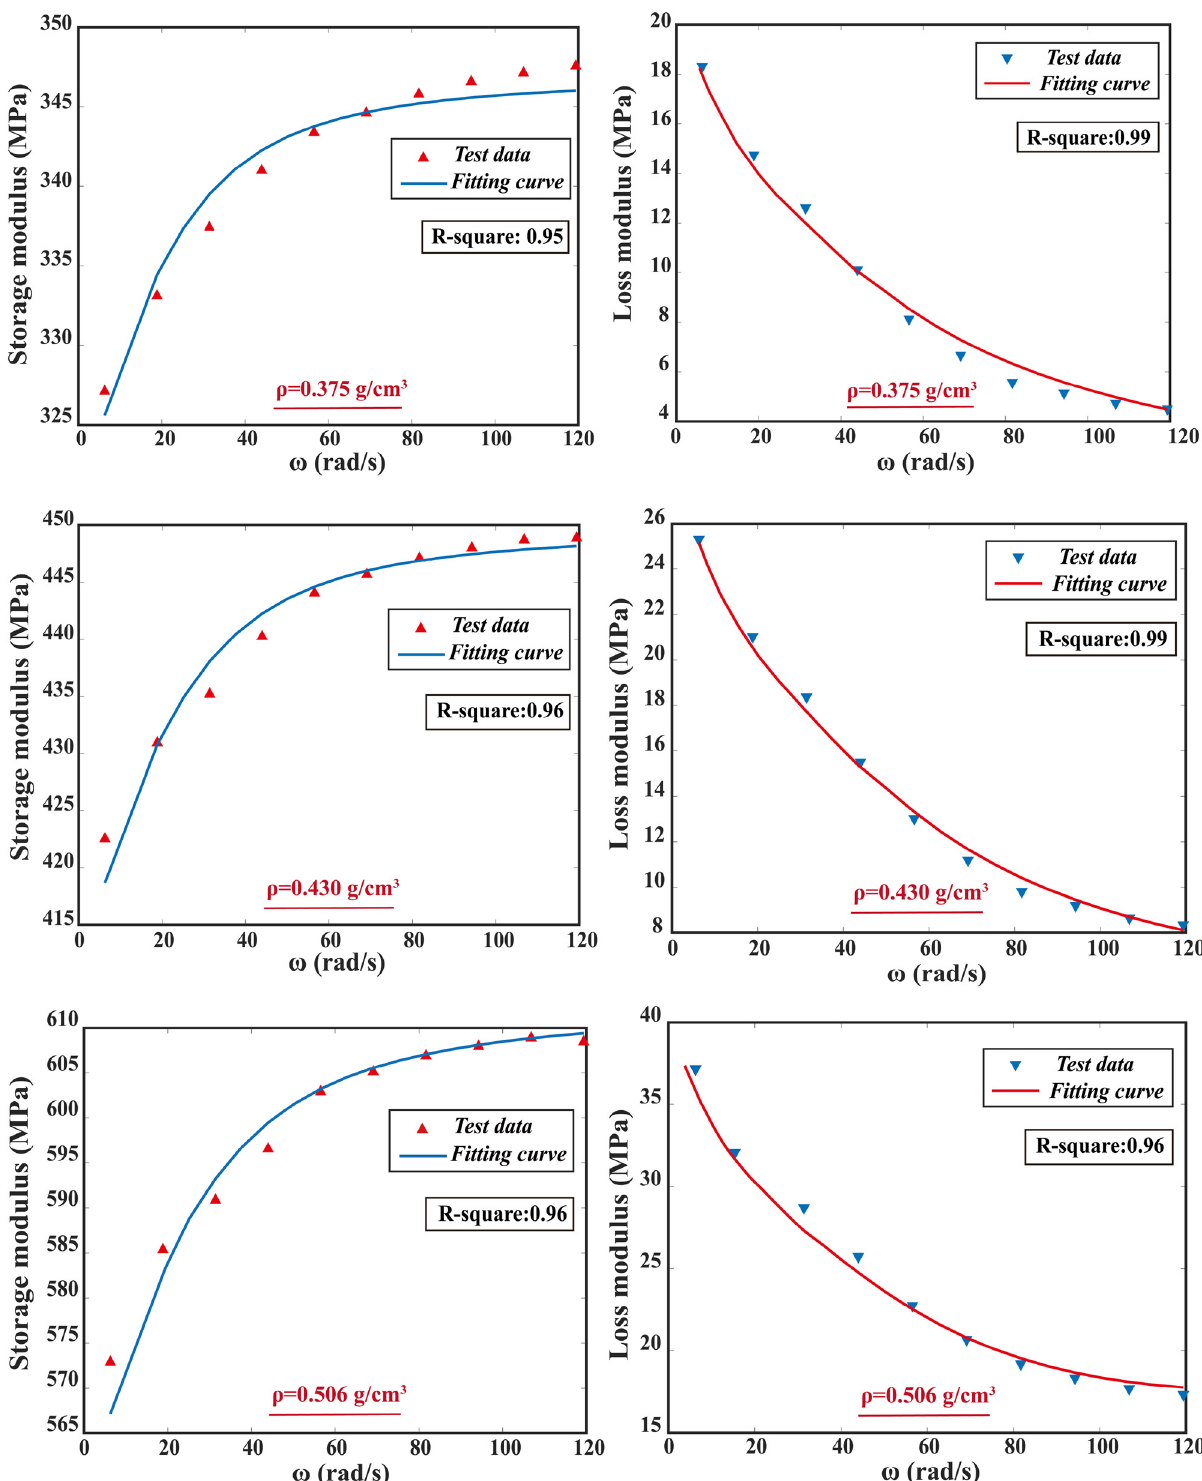
Figure 12: Fitting results of dynamic viscoelastic modulus at di ff erent